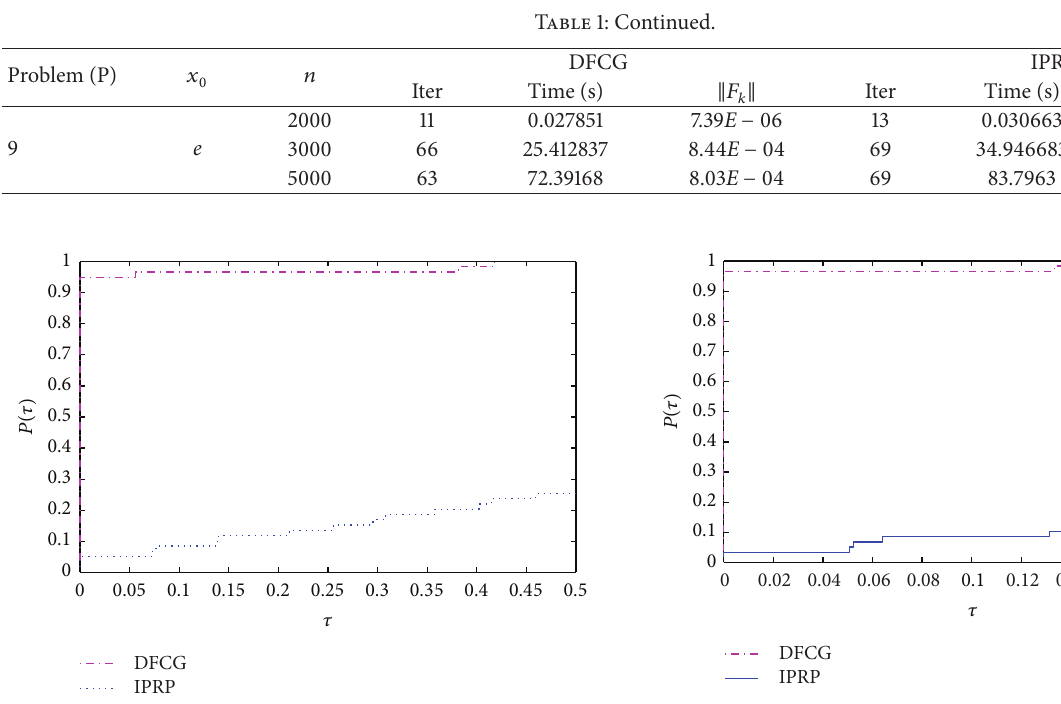
Figure 2: Comparison of the performance of DFCG and IPRP methods as the dimension increases (in terms of number of